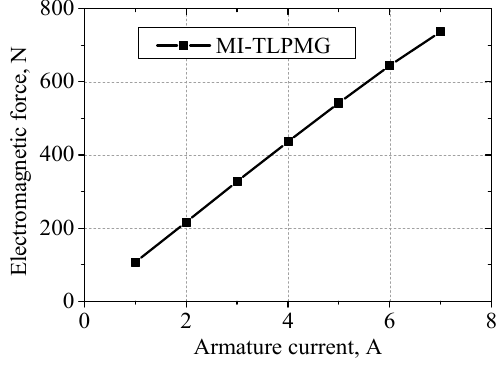
Figure 9. The maximum electromagnetic force under different armature currents.